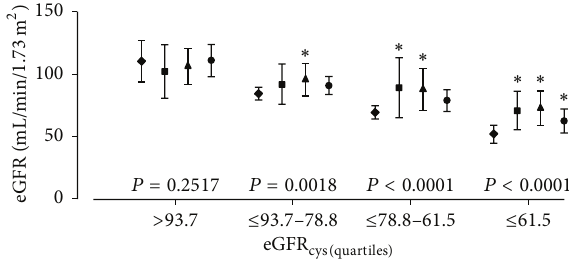
Figure 2: Mean and mean ± 1 standard deviation interval of eGFR cys ( X ), eGFR mdrd ( ◼ ), eGFR epi ( 󳵳 ), and eGFR mix ( e ) across fourths of the distribution of eGFR cys . The abbreviations eGFR cys , eGFR mdrd , eGFR epi , and eGFR mix indicate estimated glomerular filtration rate derived from serum cystatin C, from serum creatinine according to the Modification of Diet in Renal Disease or the Chronic Kidney Disease Epidemiology Collaboration equations, or from both serum cystatin C and creatinine. eGFR mdrd , eGFR epi , and eGFR mix were consistently higher ( 𝑃 < 0.0001 ) than eGFR cys except in the highest category of eGFR cys ( 𝑃 = 0.25